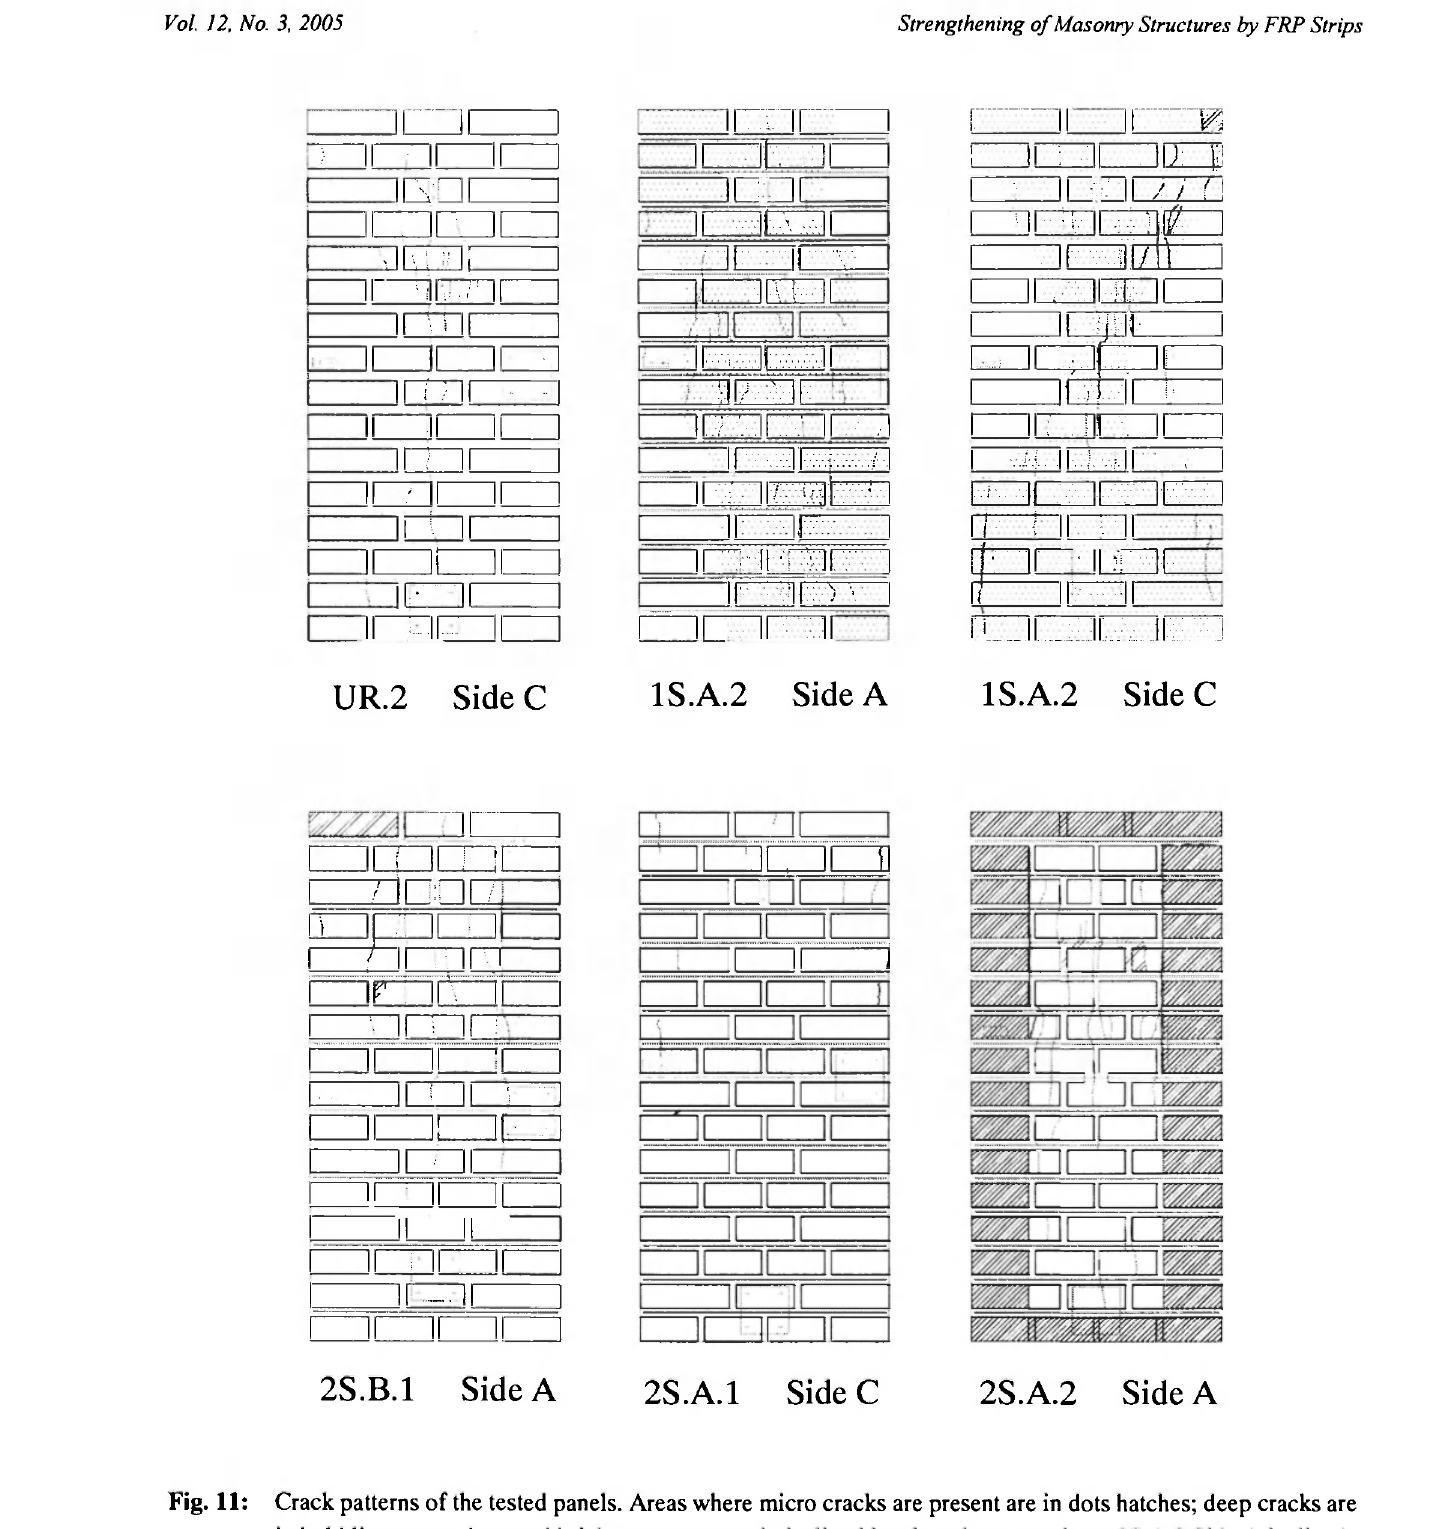
Fig. 11: Crack patterns of the tested panels. Areas where micro cracks are present are in dots hatches; deep cracks are in bold lines; very damaged bricks or mortar are in inclined hatch; only on specimen 2S.A.2 Side A inclined hatch on the perimeter represent external FRP